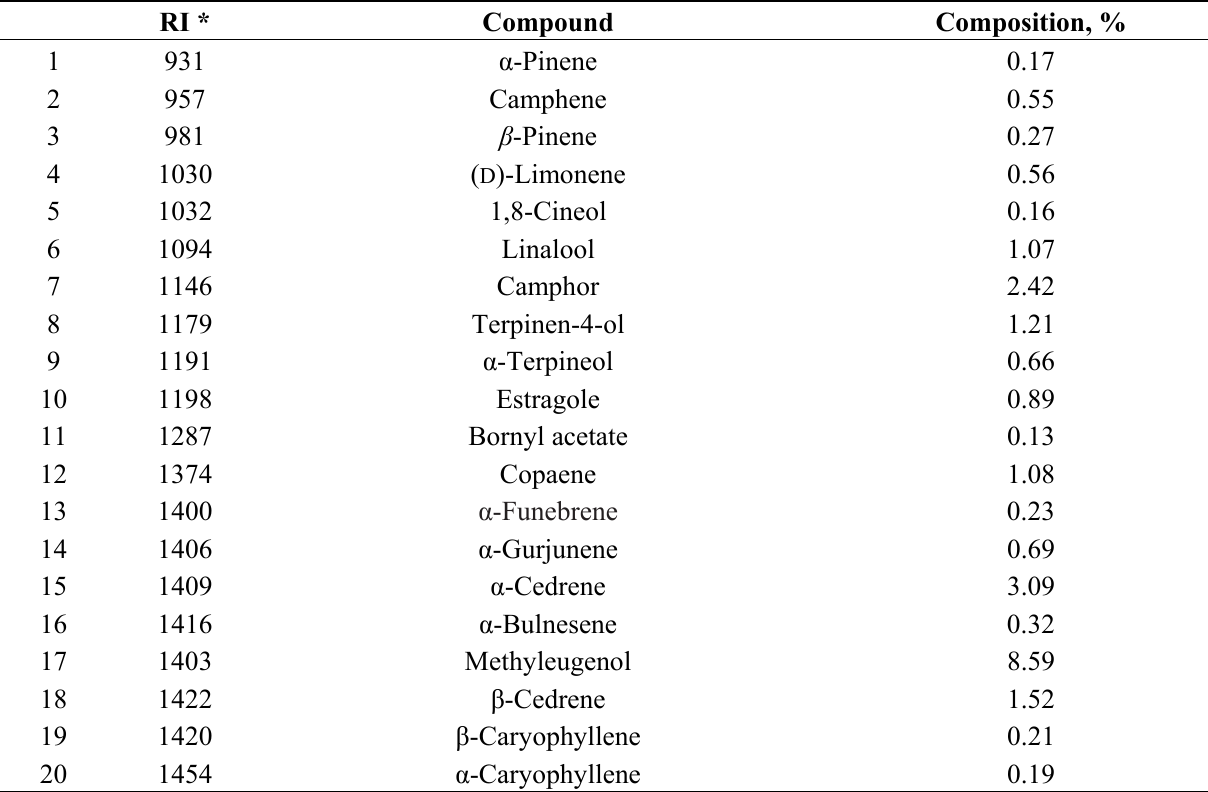
Table 1. Chemical constituents of the essential oil derived from Acorus calamus rhizomes. RI * Compound Composition,